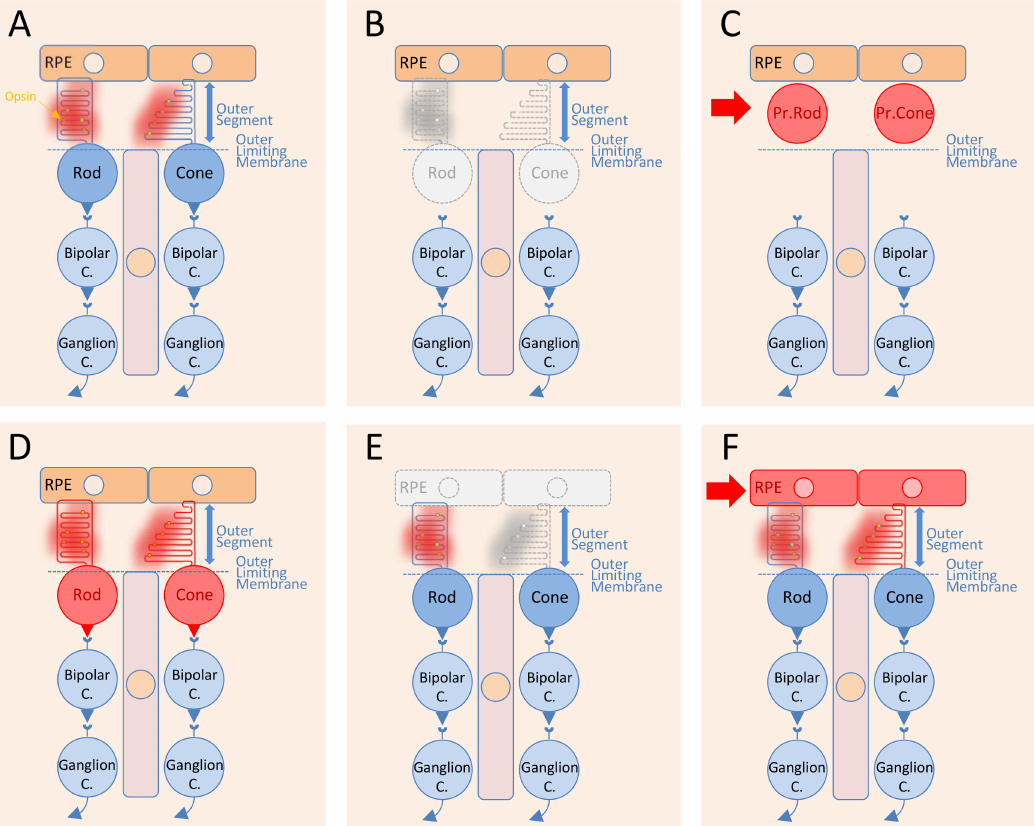
Figure 1. Illustration of the general principle of retinal cell transplantation. ( A ) Healthy retina and retinal pigmented epithelial cells. ( B ) Loss of photoreceptor cells in Mendelian inherited retinal degenerations. ( C ) Transplantation of genetically normal photoreceptor precursors (Pr. Rod or Pr. Cone) in the subretinal space of a photoreceptor-less retina. ( D ) Restoration of the synaptic connectivity of the transplanted photoreceptor precursors with the bipolar cells of the host. ( E ) Dysfunctional retinal pigmented epithelial cells leading to cone dysfunction and cone outer segment shortening at the level of the fovea in age-related macular degeneration. ( F ) Transplantation of healthy and mature retinal pigmented epithelial cells replacing the defective one from the host and restoration of cone